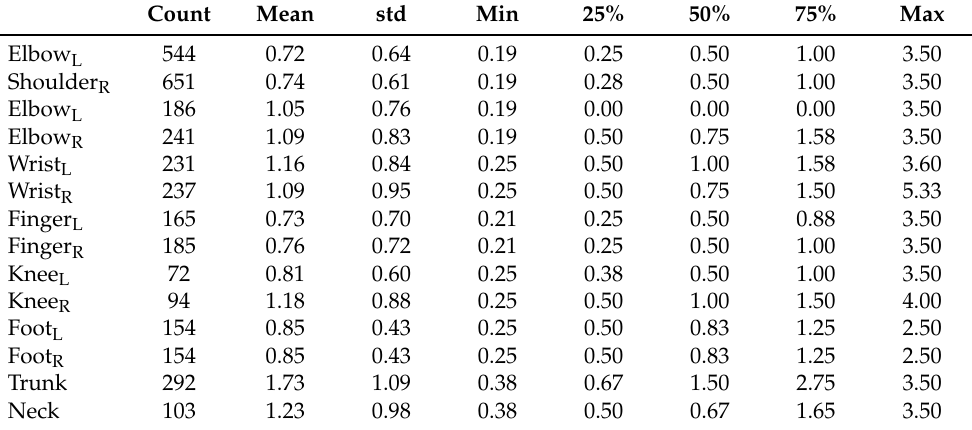
Table 4 provided, based on Neupane’s (2011) multi-site pain and work ability among an industrial population, whether the number of musculoskeletal pain sites predicts future poor work ability. Table 4. Descriptive of body parts